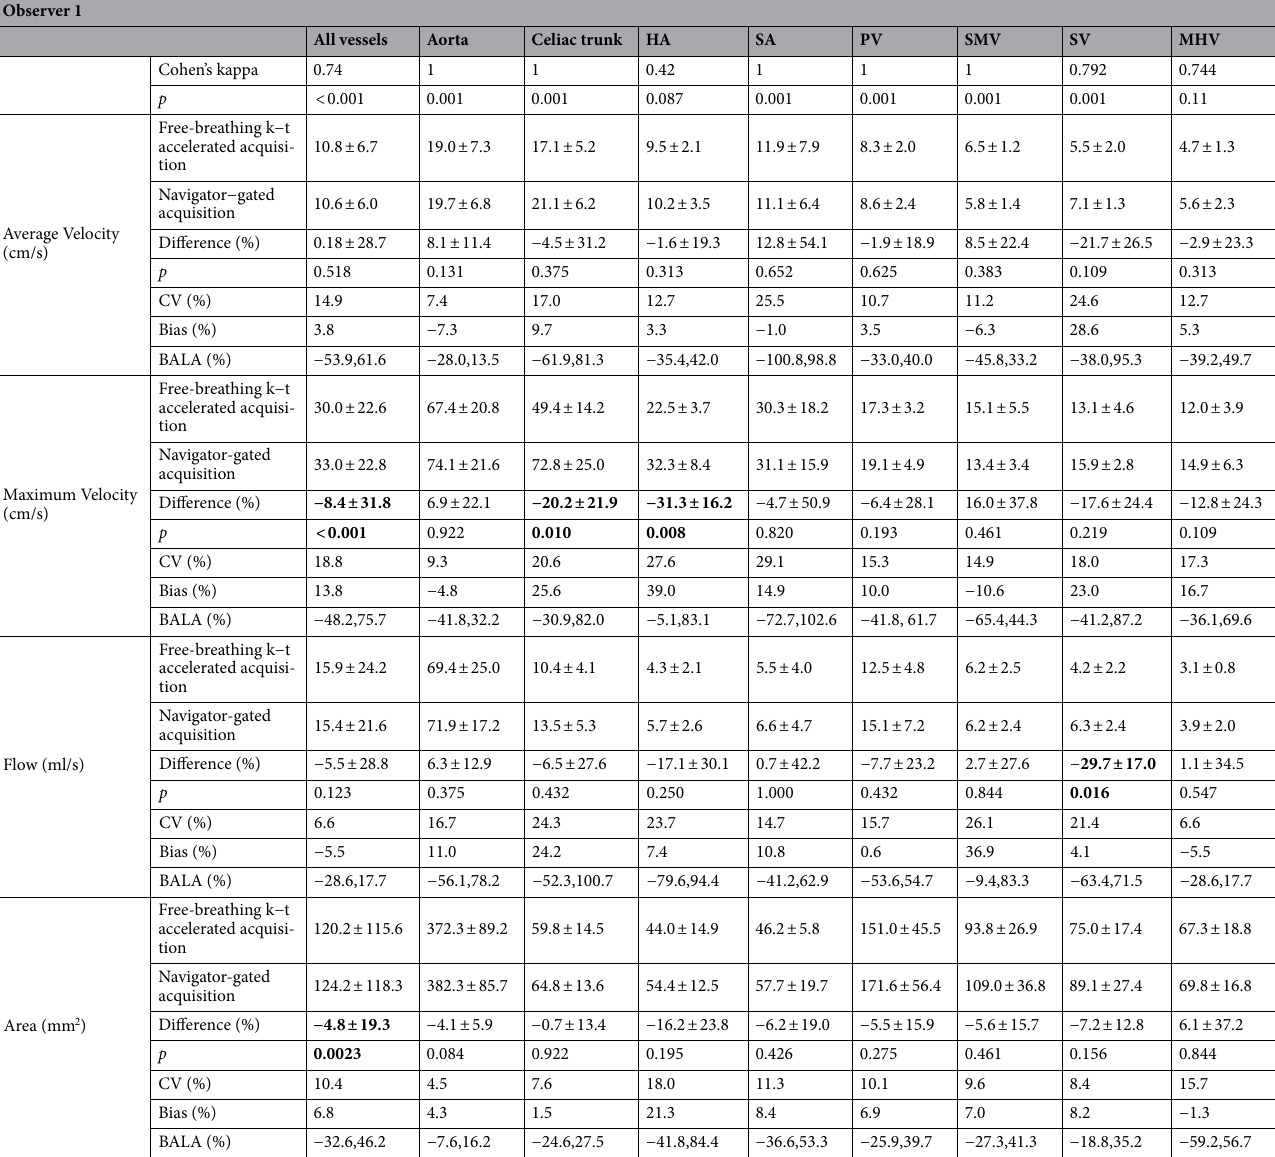
Table 3. Inter-sequence agreement in vessel identification and hemodynamic parameters measured by observer 1 on the free breathing k−t accelerated and the standard Cartesian navigator-gated acquisitions in abdominal vessels, along with intersequence differences in parameters. Agreement in vessel identification between acquisitions is measured by Cohen’s kappa. Mean and standard deviation of hemodynamic measurements with each acquisition are given for all vessels and for each individual vessel. Significant differences (paired Wilcoxon p < 0.05) in hemodynamic acquisitions are shown in bold font. Percent difference between the k−t no respiratory gating and the navigator-gated acquisition was calculated in vessels identified by both sequences as: Difference (%) = 100 x (k−t Measurement-Gated Measurement)/ Gated Measurement. Intersequence agreement of hemodynamic parameters is measured by inter-patient mean coefficient of variation (mean CV (%) = 100 SD/mean), Bland–Altman bias, and Bland–Altman limits of agreement (BALA). HA hepatic artery, MHV middle hepatic vein, PV portal vein, SA splenic artery, SMV superior mesenteric vein, SV splenic